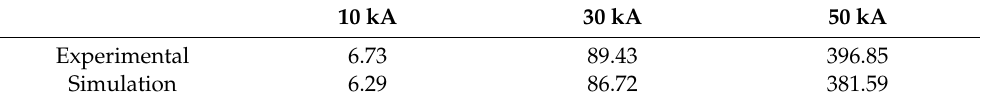
Table 3. Comparison of surface ablation damage area (mm 2 ) between experiment and